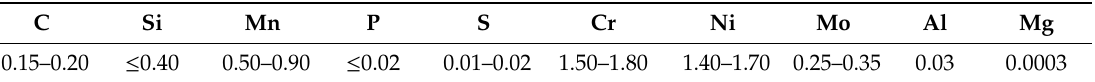
Table 1. Chemical composition of gear steel 18CrNiMo7-6 (wt